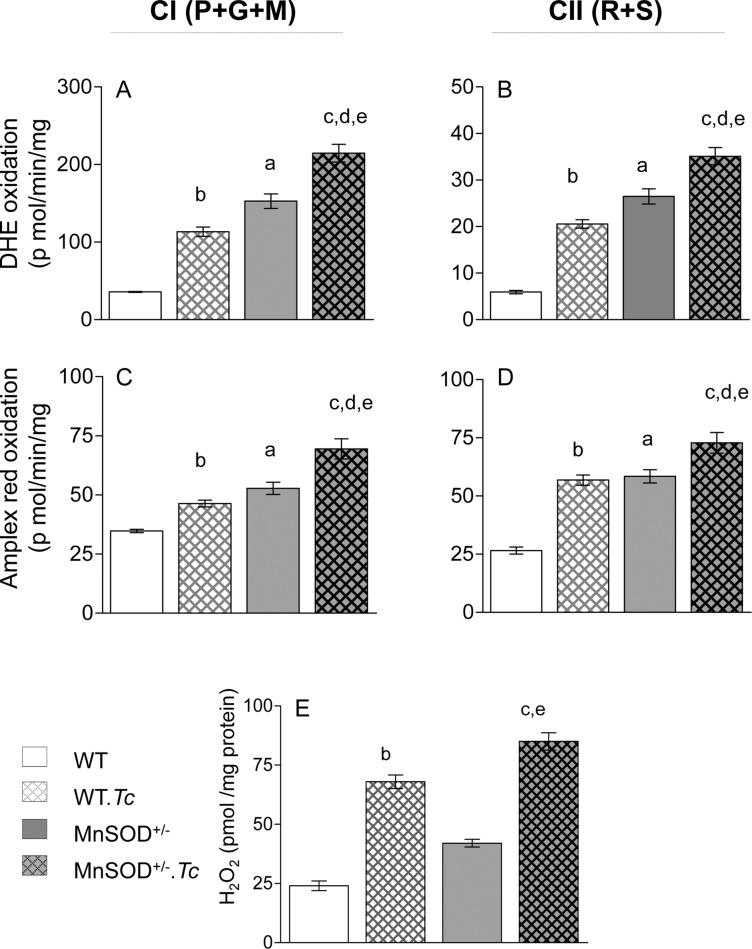
Effects of MnSOD deficiency on mitochondrial and cardiac ROS in chagasic mice.C57BL/6 (WT and MnSOD+/-) mice were sacrificed at 150 days pi. (A-D) Freshly isolated cardiac mitochondria were incubated in presence of pyruvate/glutamate/malate (P+G+M) to support electron flow through complex I (A&C) or with rotenone/succinate (R+S) to support electron flow through complex II (B&D). The ROS production was measured by oxidation of dihydroethidium (DHE) to fluoresecent ethidium (A&B) and amplex red oxidation to resorufin (C&D). (E) Myocardial H2O2 levels were determined by an amplex red assay as described in Materials and Methods. Data are plotted as mean value ± SEM (n = 6 mice per group, triplicate observations per mouse). Statistical significance are marked as aMnSOD+/- vs. WT, bWT.Tc vs. WT, cMnSOD+/-.Tc vs. MnSOD+/-, dMnSOD+/-.Tc vs. WT.Tc, and eMnSOD+/-.Tc vs. WT (p value < 0.05).